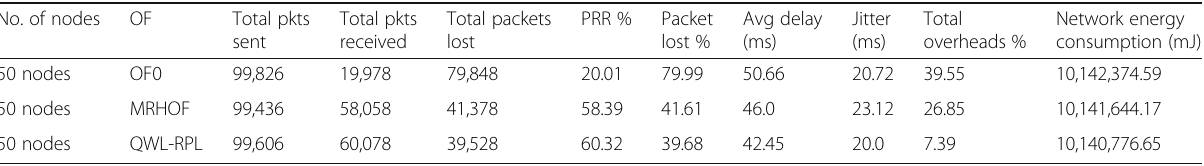
Table 9 Analysis of random topology with varying heterogeneous traffic load No. of nodes